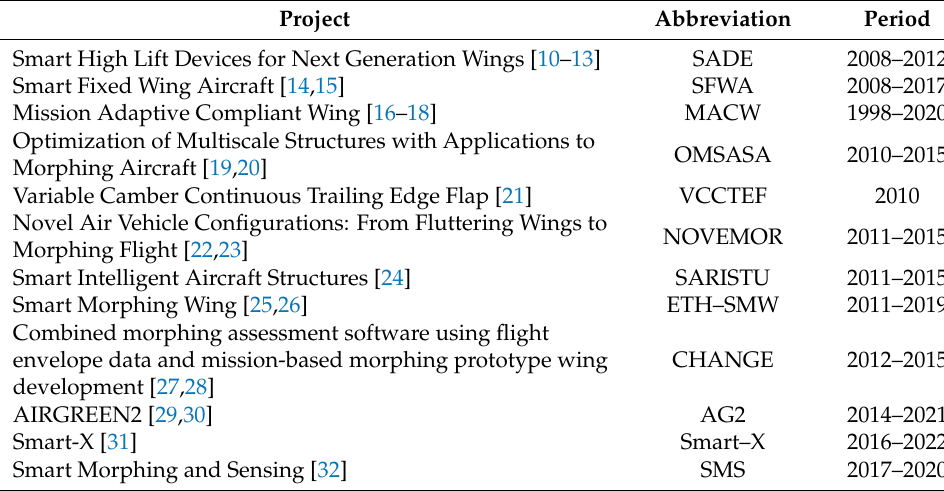
Table 1. Major variable camber wing research